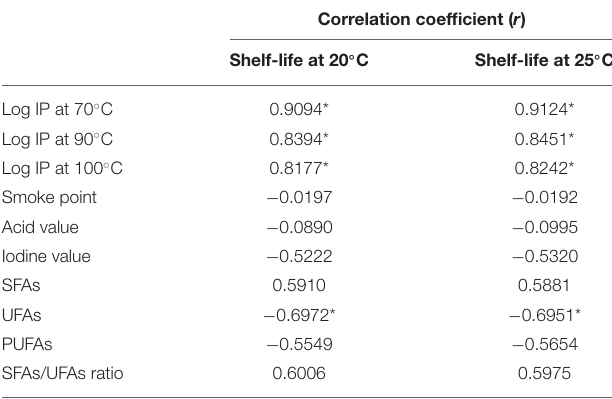
TABLE 5 | Correlations of log induction period (IP) value, smoke point, acid value, “iodine value, and fatty acid compositions” with the shelf-life of nine expeller-pressed